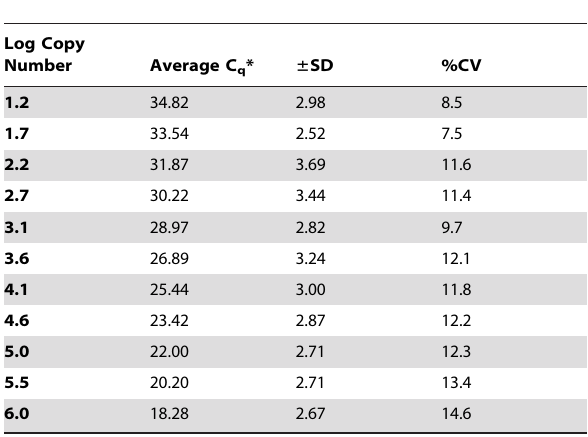
Table 3. The amplification efficiency of qMSP and qBSP standard